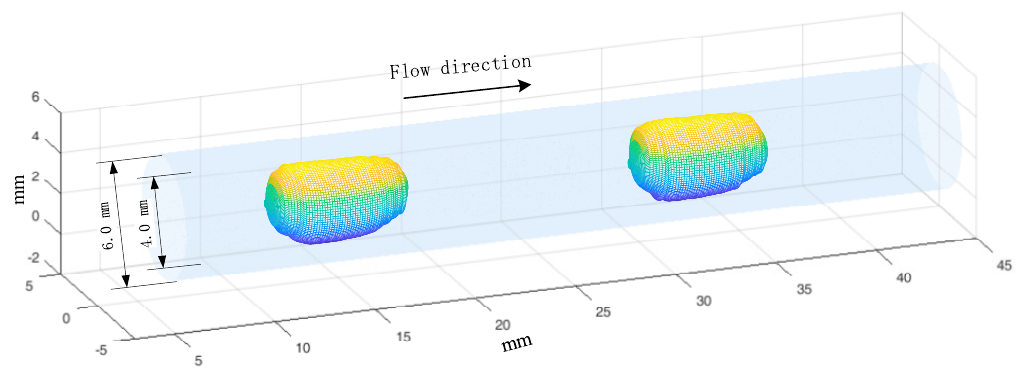
Sensors 2019 , 19 , x FOR PEER REVIEW Figure 13. 3D reconstruction results of slug flow (velocity 0.15 m/s, void fraction 0.25). Figure 13. 3D reconstruction results of slug flow (velocity 0.15 m / s, void fraction 0.25).